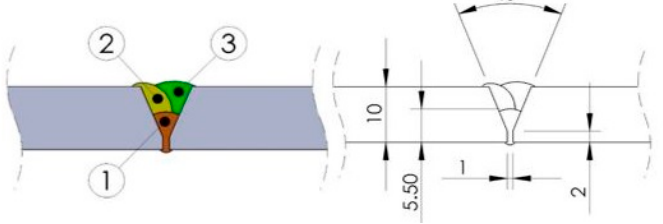
Figure 6. Welding sequence and bead dimensions for butt-joint (mm unit).